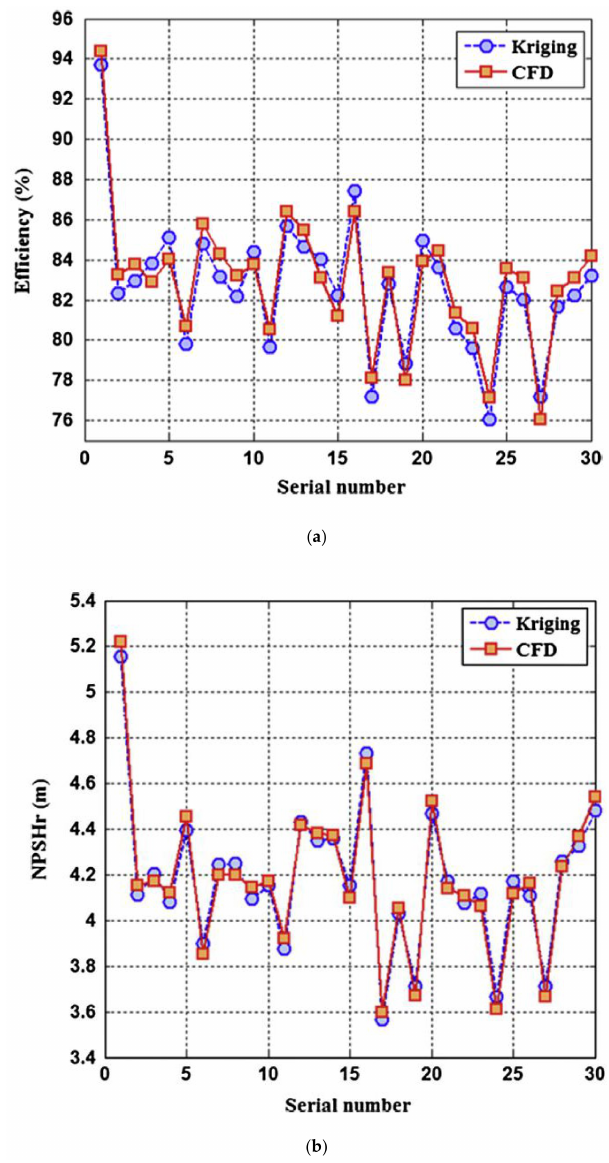
Figure 16. SKE approach and CFD comparison ( a ) efficiency, ( b ) NPSH r